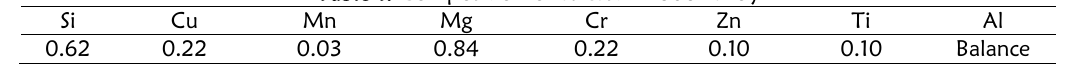
Table 1: Composition of as-cast AA6061 alloy